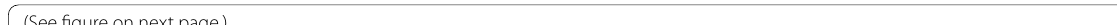
figure on next Fig. 4 Repeated dural IS stimulation induced gliosis and neuronal loss in the cerebral cortex and hippocampus, but no obvious white matter damage. ( a - d ) Representative immunofluorescence analysis showed an increase in Iba-1 positive microglia and GFAP positive astrocytes in the cortex and hippocampus following dural IS stimulation, indicating microgliosis and astrogliosis. Magnification 40. Insets show a higher × magnification view. Scale bar, 20 μm. ( e – f ) Representative immunofluorescence images showed a decrease in MAP2-positive areas (an indicator of neuronal loss) in the cerebral cortex and hippocampus, but no significant change in MBP-positive areas (an indicator of white matter integrity) after repeated dural IS stimulation. Magnification 20. Scale bar, 20 μm. ( g - h ) Representative crystal violet images and quantification showed the loss × of Nissl-positive neurons in the cortical and hippocampal CA3 regions after repeated dural IS stimulation. Magnification 40. Scale bar, 20 μm. ( i - j ) × Representative Luxol fast blue stained images and quantification showed no obvious white matter lesion in the corpus callosum (medial), corpus callosum (paramedian), caudoputamen, internal capsule, and optic tract after repeated dural IS stimulation. The severity of white-matter disruption was graded accordingly: Grade 0 no disruption; Grade 1 disarrangement of nerve fibers; Grade 2 formation of marked vacuoles; Grade = = = 3 disappearance of myelinated fibers. Magnification 20. Scale bar, 20 μm. All images were taken under identical exposures and conditions. = × n 6 mice per group. * p < 0.05, ** p < 0.01 and *** p < 0.001 as compared to sham mice. Datasets in (j) were conducted with Mann–Whitney U test; = the other datasets were analyzed using Student’s t test. Data are represented as mean SEM. Abbreviations: IS, inflammatory soup; Iba-1, ionized ± calcium-binding adaptor molecule-1; GFAP, glial fibrillary acidic protein; MAP2, microtubule-associated protein 2; MBP, myelin basic